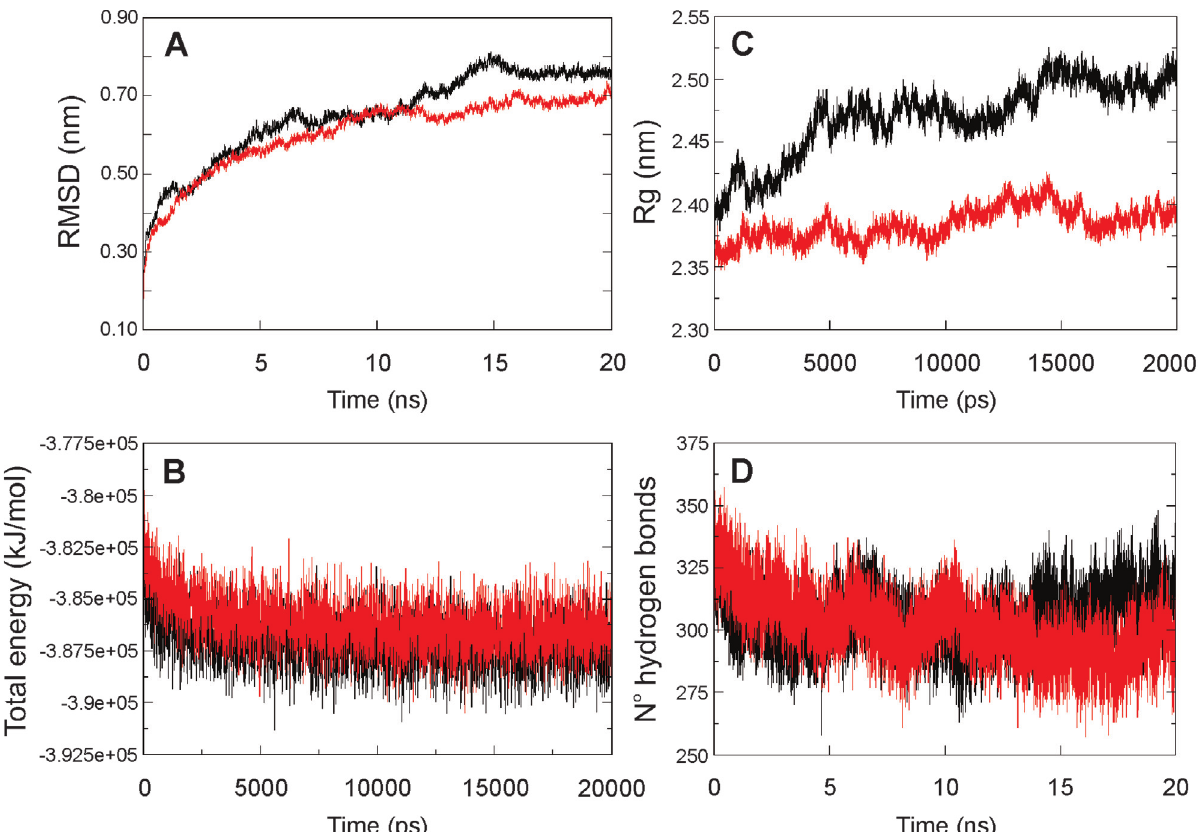
Figure2 -AnalysisoftwoHvAACT1proteinsthatdifferedonlyatresidue172.RedlinesindicatetheHvAACT1proteinwithL-172andblacklinesindi- catetheproteinwithV-172.Thepanelsshowtheresultsfortherootmeansquaredeviation (A) ,totalenergy (B) ,radiusofgyration (C) andnumberofhy- drogen bonds (D)